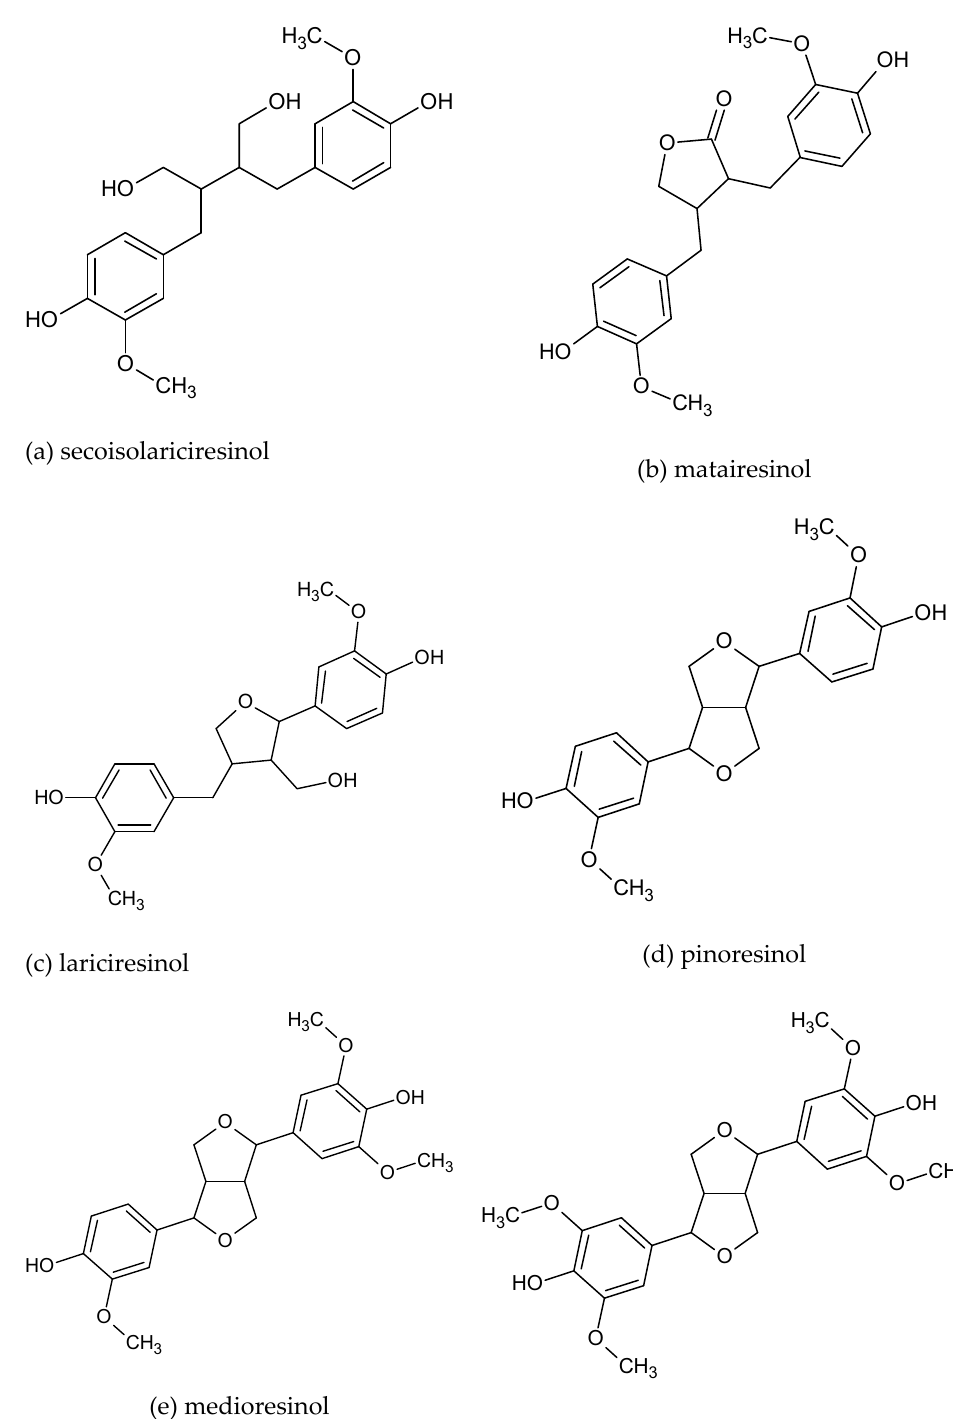
Figure 1. The chemical structure of main dietary lignans, ( a ) secoisolariciresinol, ( b ) matairesinol, ( c ) lariciresinol, ( d ) pinoresinol, ( e ) medioresinol, and ( f ) syringaresinol. Plant lignans give rise to metabolites, enterodiol, and enterolactone [12], generally called enterolignans due to their colonic origin (named also mammalian lignans) (shown in Figure 2).